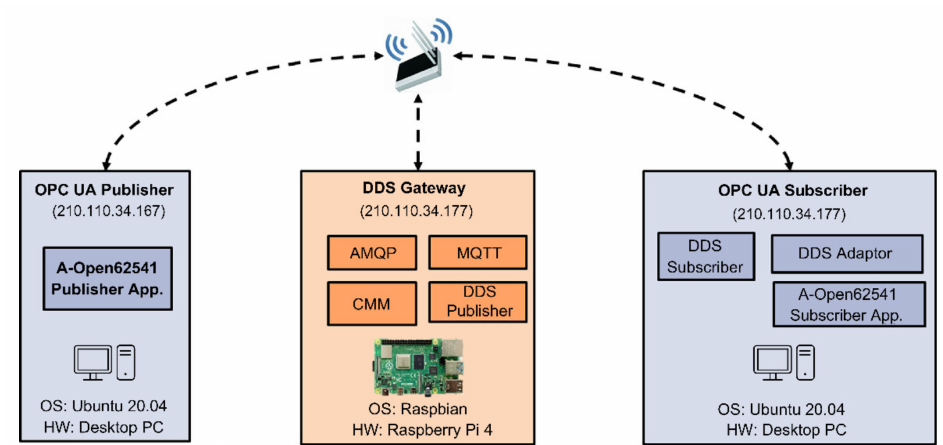
Figure 12. Testbed configuration used for proof of concept.